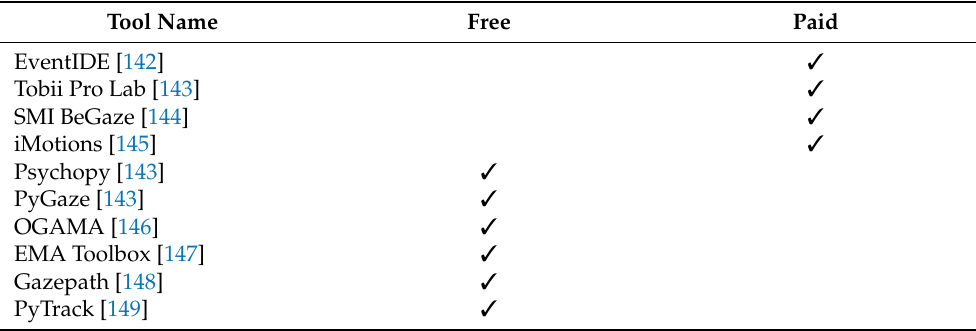
Table 6. Names of open-source and commercial tools for recording and analyzing the experimental study using